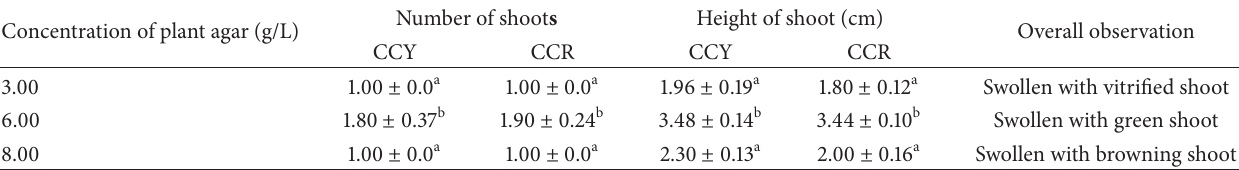
Table 2: Effects of different agar concentrations on shoot production of C. crotalifera (CCR and CCY). Concentration of plant agar (g/L)